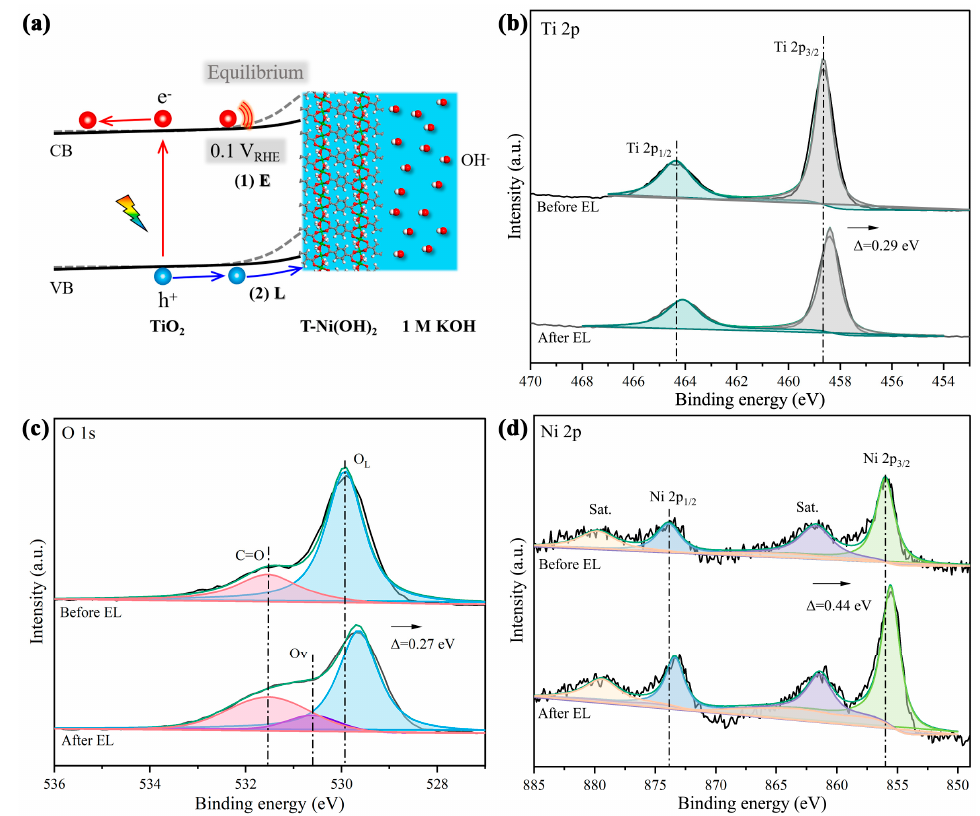
Figure 7. ( a ) In situ-transition mechanism of Ni-MOF on the surface of T-Ni(OH) 2 @TiO 2 under EL treatment. Dash line: equilibrium state. Solid line: at the potential of 0.1 V RHE . ( b ) Ti 2p, ( c ) O 1s, and ( d ) Ni 2p XPS spectra of T-Ni(OH) 2 @TiO 2 before and after 6 h EL treatment. The X-ray photoelectron spectroscopy (XPS) spectra of T-Ni(OH) 2 @TiO 2 before and